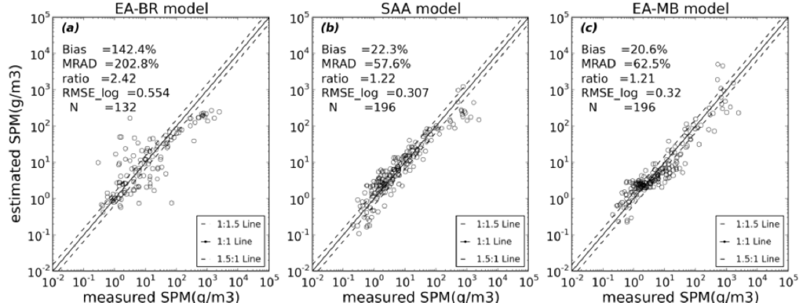
1 numbers shown in parentheses in EA-MB-L, EA-MB-H, SAA-L, SAA-H, EA-BR-L and EA-BR-H rows represent corresponding statistics when EA-MB, SAA and/or EA-BR model are applied instead.